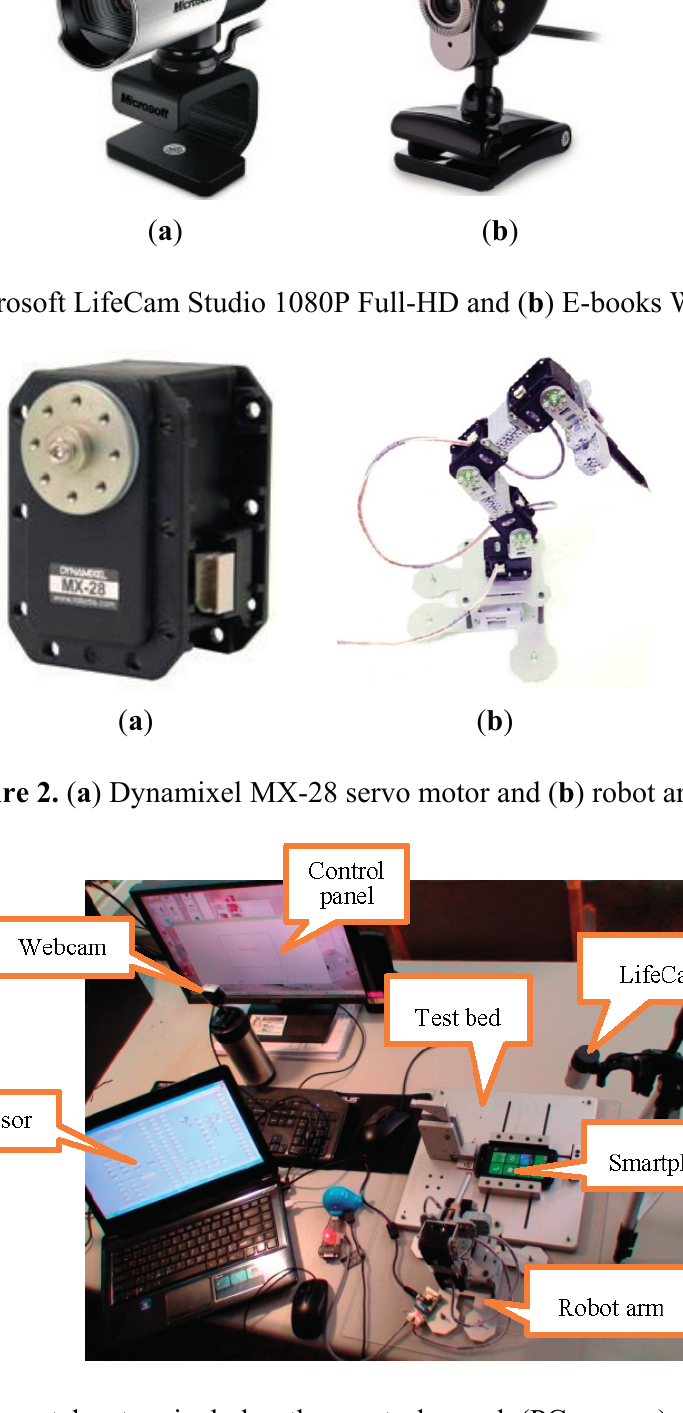
Figure 3. Experimental setup includes the control panel (PC screen), main processor (notebook), Microsoft LifeCam, E-books Webcam, robot arm, tested smartphone, and test